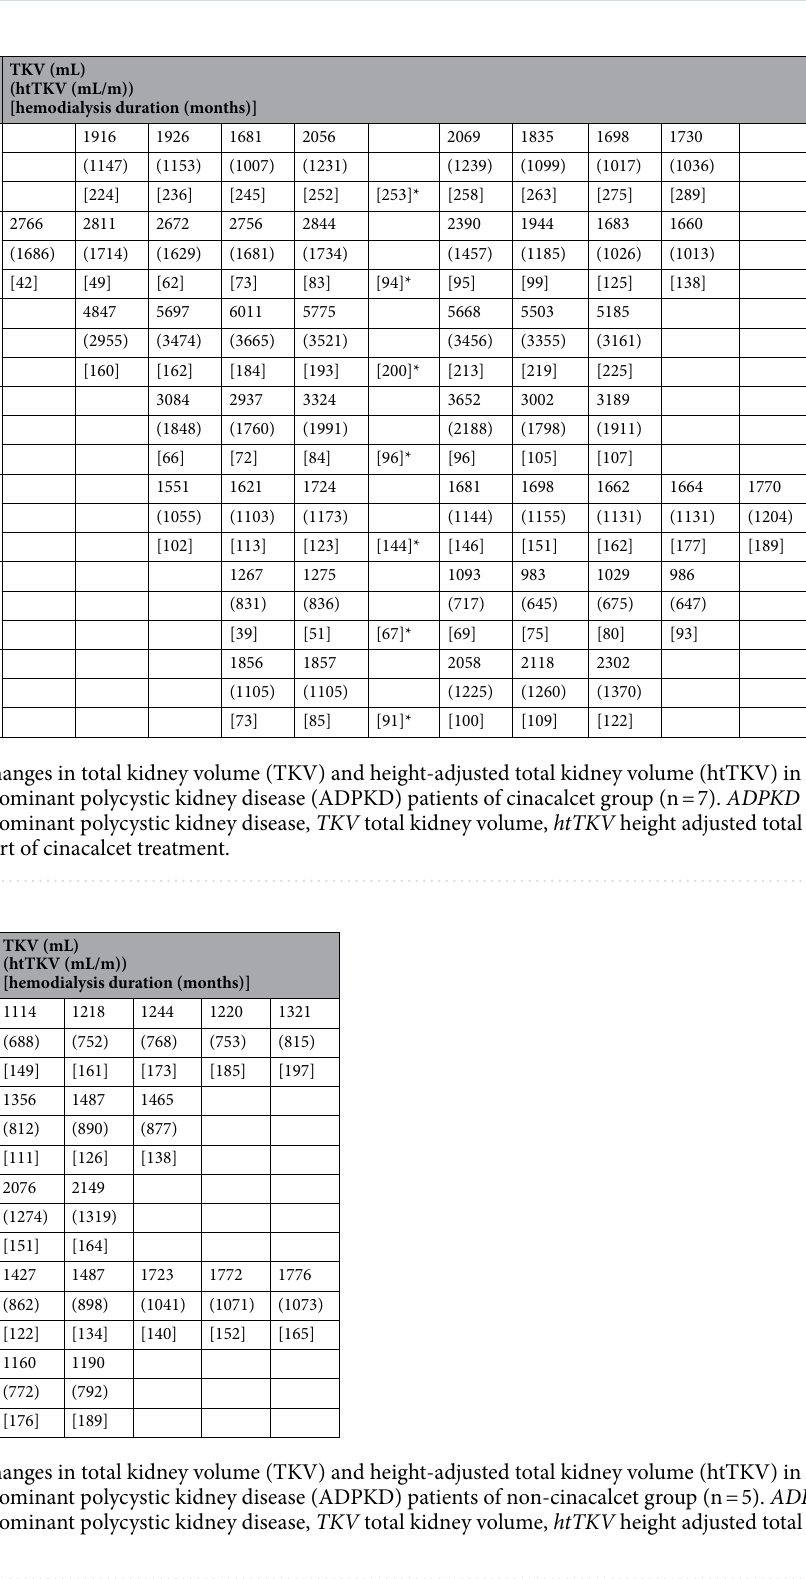
changes in serum calcium, phosphate, and intact PTH levels after treatment with cinacalcet in hemodialysis patients with ADPKD. During the cinacalcet treatment observational period, the average drug dosage was 28.7 ± 13.7 mg/day. Patients who received cinacalcet treatment showed significantly decreased serum intact PTH levels, from 489 ± 285 pg/mL at baseline to 229 ± 138 pg/mL at the end of the observation period ( p = 0.032).